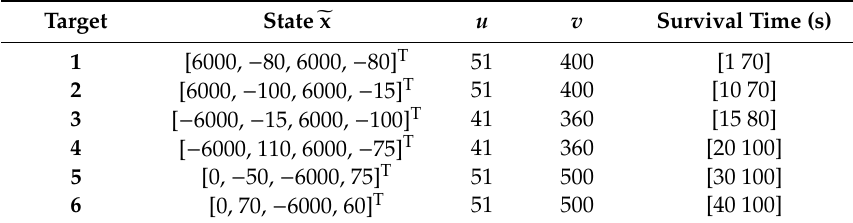
Table 1. The target initial states.